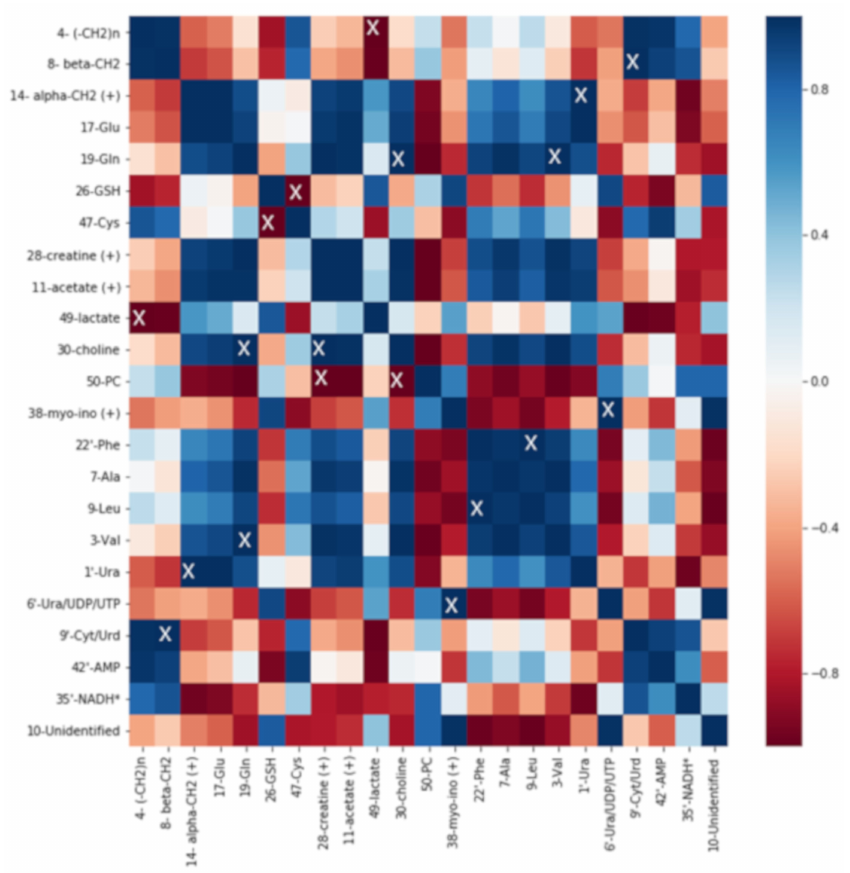
Figure 9. Heatmap of A2780 cells treated with 0.03 µ M of DiRu-1 vs. control: The blue color scale has been used for positive correlation, and the red scale is for negative correlation. “X” indicates significances with p -values < 0.05. * Tentative assignment. ( + ) stands for the possibility that some other metabolite is contained in the bucket in question in addition to the assigned